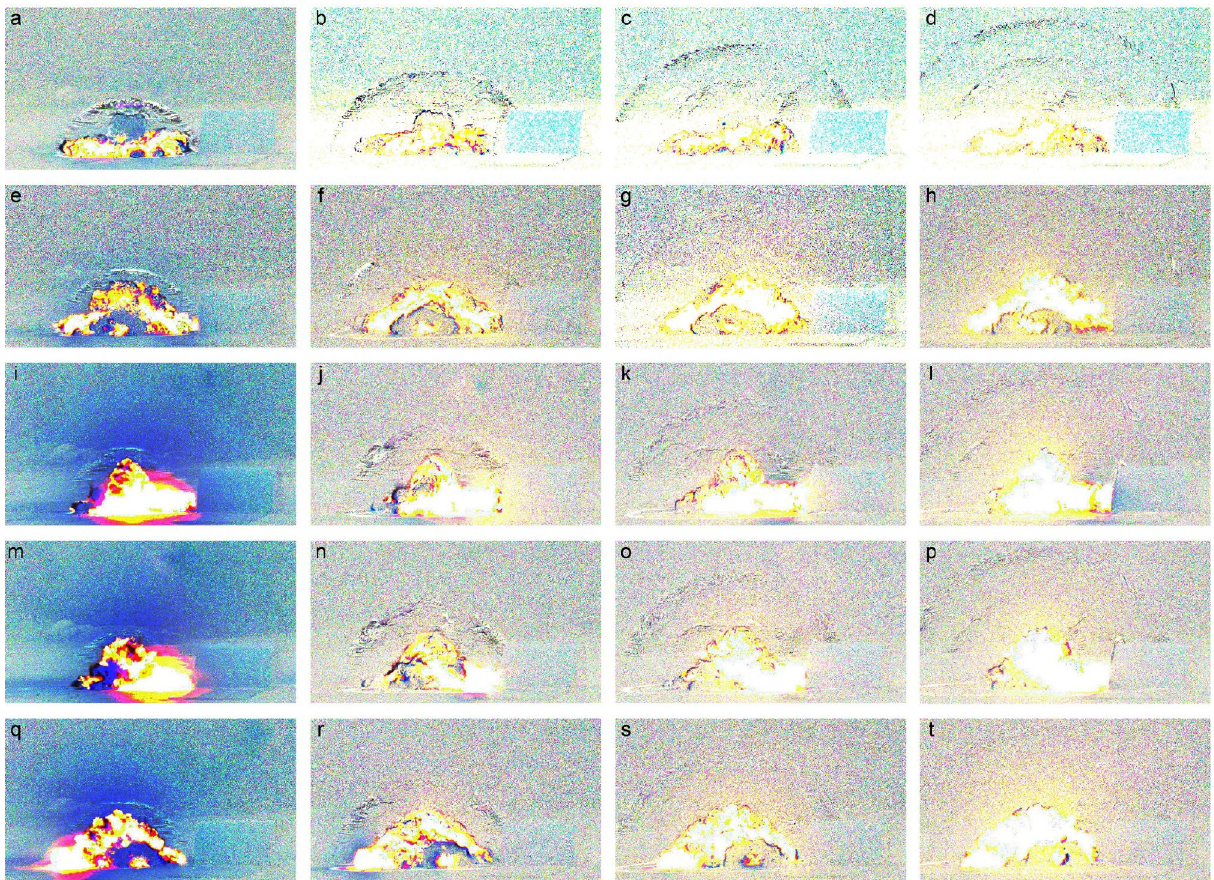
Figure 5. The blast waves at 1 ms, 2 ms, 3 ms, and 4 ms. ( a-d ) Case 1. ( e–h ) Case 2. ( i-l ) Case 3. ( m-p ) Case 4. ( q-t ) Case